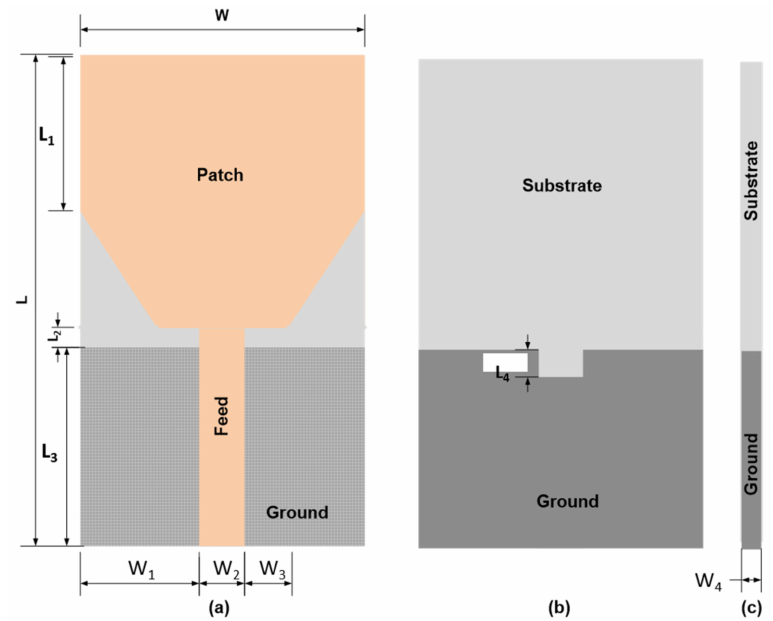
Figure 1. Structure of the rectangular patch ( a ) front, ( b ) side, ( c ) ground